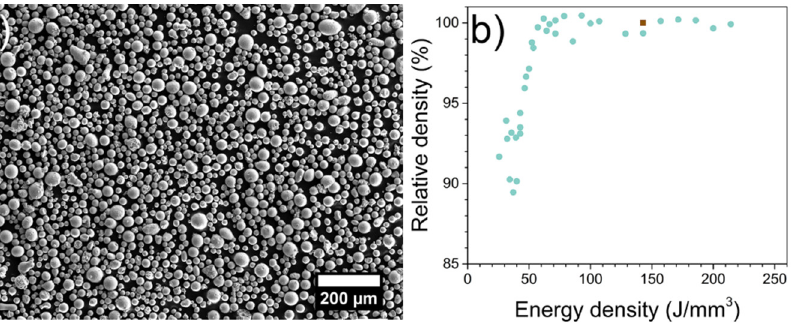
Figure 1. ( a ) SEM image showing the spherical morphology of the feedstock powder and ( b ) relative density of samples built at different process parameters. The brown square shows the relative density of the samples, with a build plate temperature of 200 °C, selected for further studies.